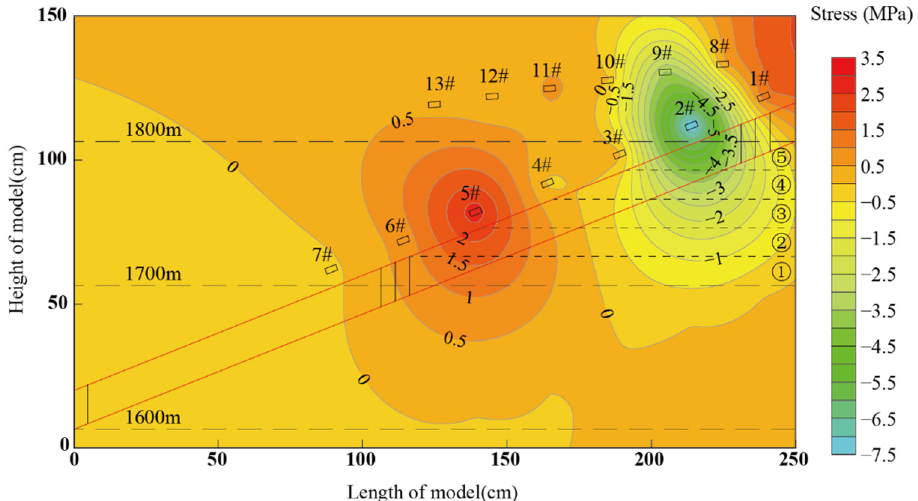
Figure 11. Contour of stress increment of filling mining to the fifth sublevel.